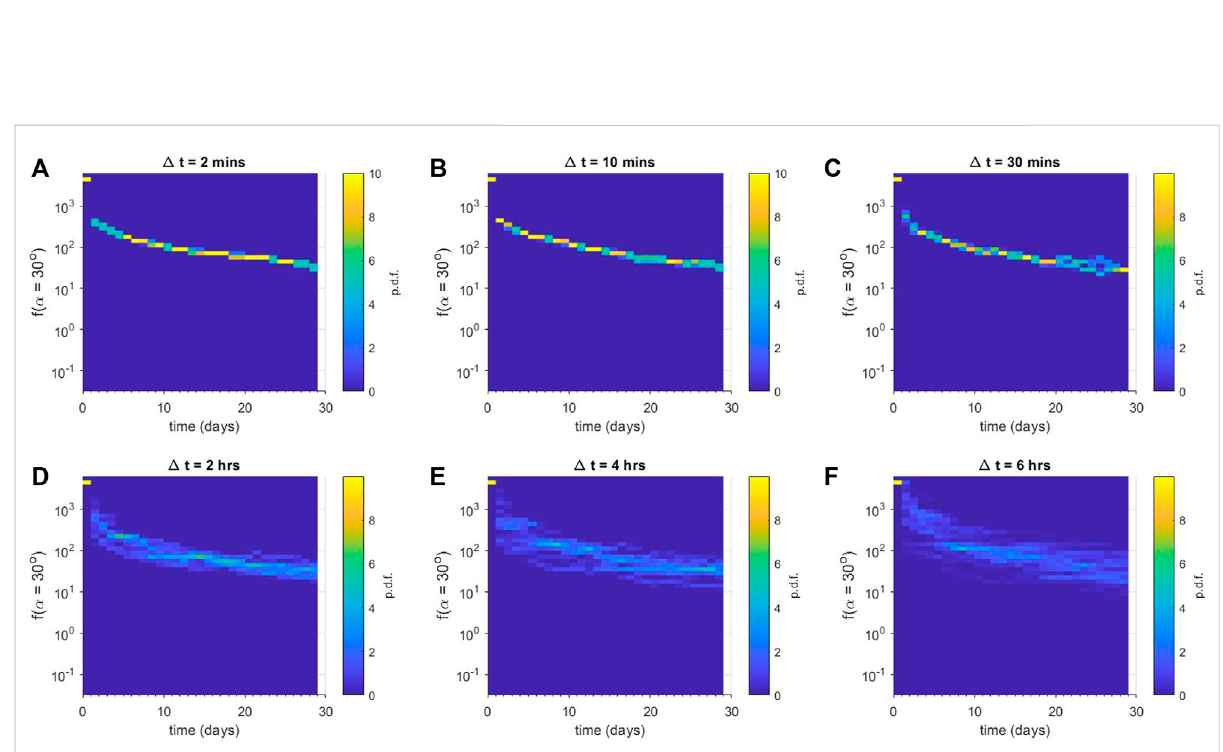
Ensemble results for numerical diffusion experiments using D αα ( L * = 2.5). Each panel shows a column-normalised probability distribution functionforthephasespacedensity f justoutsidetheloss-cone α LC for (A) Δ t =2 min, (B) Δ t =10 min, (C) Δ t =30 min, (D) Δ t =2 h, (E) Δ t =4 h,and (F) Δ t = 6 h. Note that each histogram is displayed using the same vertical binning, giving the histograms a pixelated